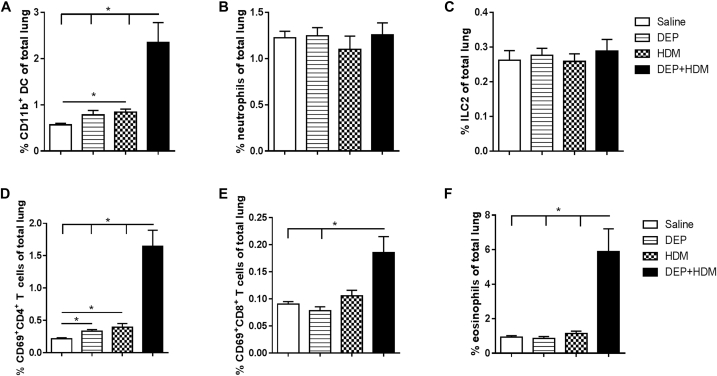
Adjuvant effect of DEPs on HDM-induced airway inflammation in the lung. WT mice were exposed to saline (white bars), 25 μg of DEPs (striped bars), 1 μg of HDM (checked bars), or DEP+HDM (black bars) on days 1, 8, and 15. A-F, DCs (CD11c+MHCII+CD11b+; Fig E4, A), neutrophils (CD11c−CD11b+Ly6G+Ly6C+; Fig E4, B), eosinophils (CD11c−CD11b+Siglec-F+; Fig E4, C), ILC2s (Lin− [CD3−, CD5−, NK1.1−, TCRβ−, CD11c−, CD11b−, and CD45R−] CD25+CD90+; Fig E4, D), CD4+ T cells (CD3+CD4+CD8−CD69+; Fig E4, E), and CD8+ T cells (CD3+CD8+CD4−CD69+; Fig E4, F) in lung tissue were determined by using flow cytometry. Results are expressed as the mean percentages of total lung ± SEM (n = 7-8 mice per group). *P < .05.